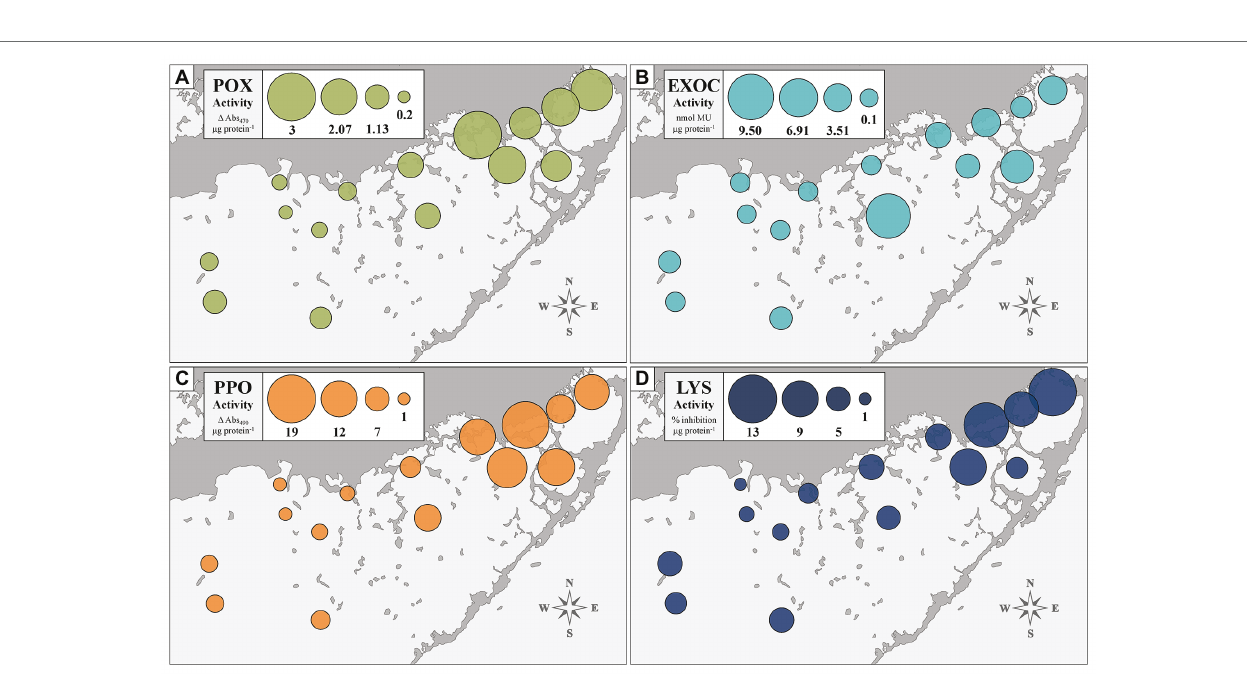
FIGURE 2 | Immune enzyme activities of four biomarkers (POX, EXOC, PPO, and LYS: A–D ) in turtlegrass among 15 Florida Bay study sites. Sizes of bubble plots layered over site locations represent magnitude of biomarker activity averaged across the 10 individuals collected at that